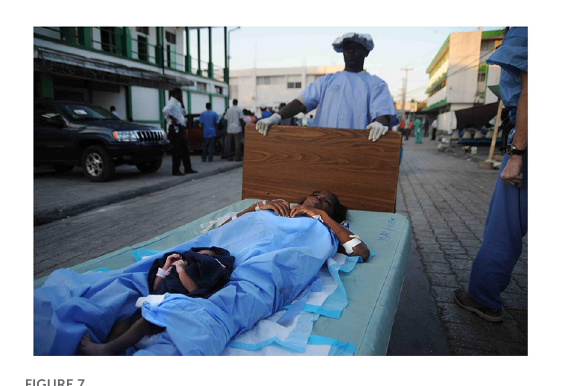
FIGURE7 Medical personnel transport a Haitian woman and her new-born son to the post-operating room at the University Hospital in Port-Au-Prince, Haiti, January 20, 2010. VIRIN: 100120-n-6070s-016. Photograph: Petty Officer 2nd